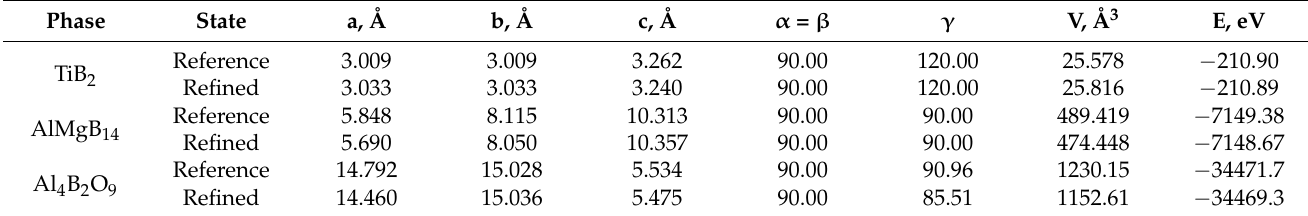
Table 2. Structural parameters of the detected phases.